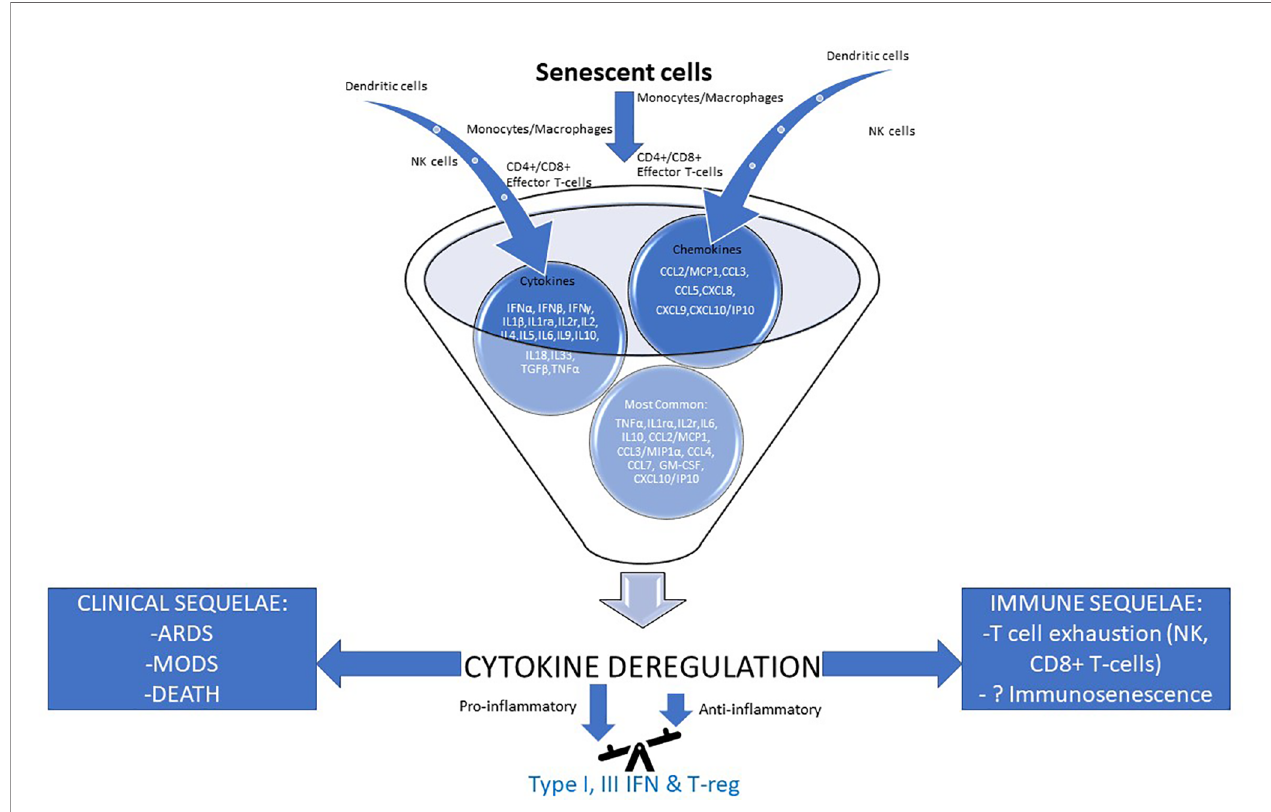
FIGURE 6 | Cytokine deregulation seems to play a pivotal role in the pathogenesis of severe COVID-19. Severe/critical disease outcomes for COVID-19 have been associated with an excessive immune response leading to cytokine deregulation which underpins unfavorable immune (right) and clinical (left) sequelae. Effector cells ’ input of cytokines and chemokines is depicted, while their most common pro fi le can also be seen. In the foundation of cytokine deregulation lies an unbalanced pathological immune response with major pro- and little anti-in fl ammatory contribution secondary to at least in part, impaired IFN type I & III and T-reg actions (87, 110 – 112). ARDS, acute respiratory distress syndrome; CCL, C – C motif chemokine ligand; CXCL, C-X-C Motif Chemokine Ligand; GM-CSF, Granulocyte-macrophage colony- stimulating factor; IFN, interferon; IL, interleukin; ILr, interleukin receptor; IP10, Interferon gamma-induced protein 10; MCP1, monocyte chemoattractant protein-1; MIP1a, macrophage in fl ammatory protein alpha; MODS,multiple organ disfunction syndrome; NK cells, natural killer cells; TGF- b , transforming growth factor beta; TNF-a, tumor necrosis factor a; T-reg, regulatory